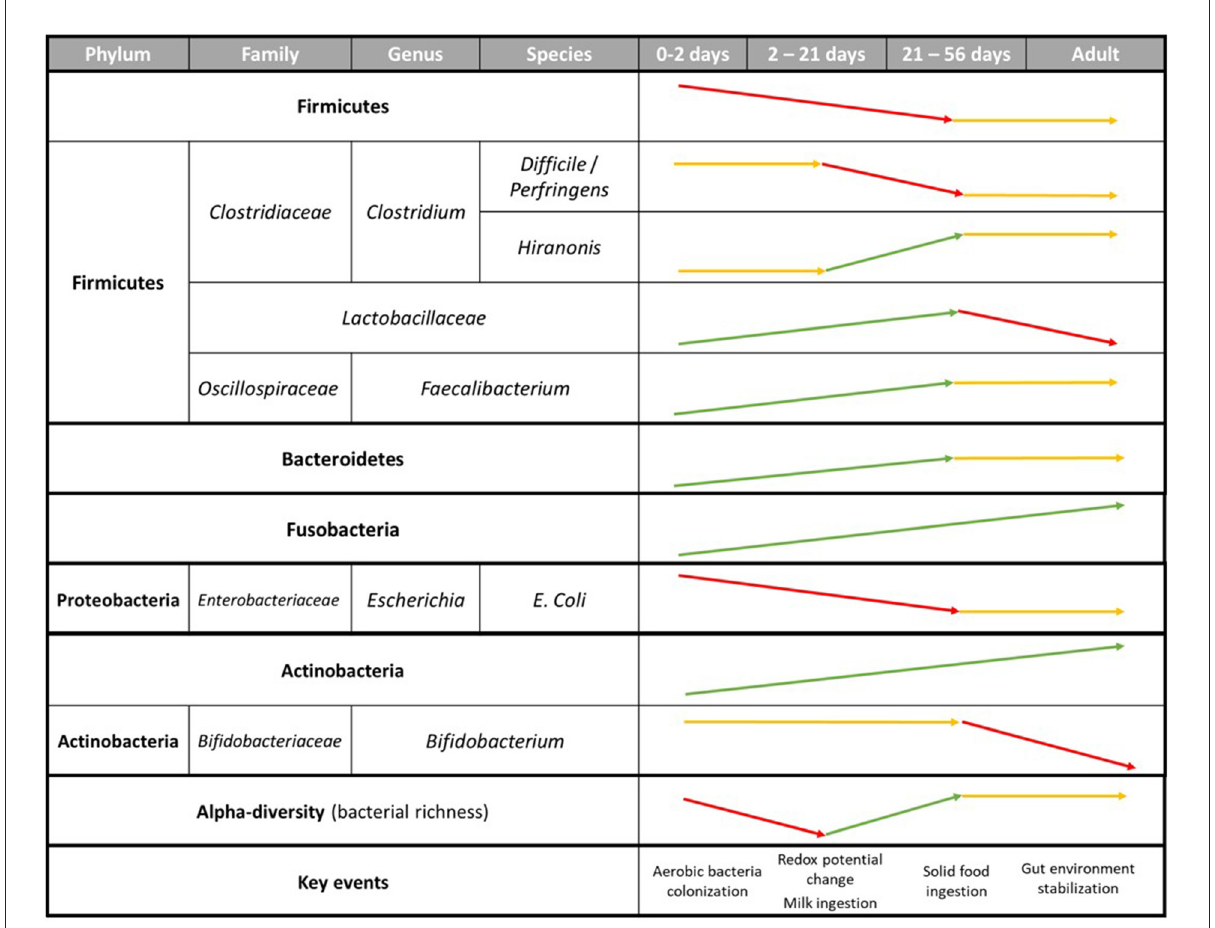
FIGURE1 Summary of the evolution of main fecal bacterial groups in puppies from birth to